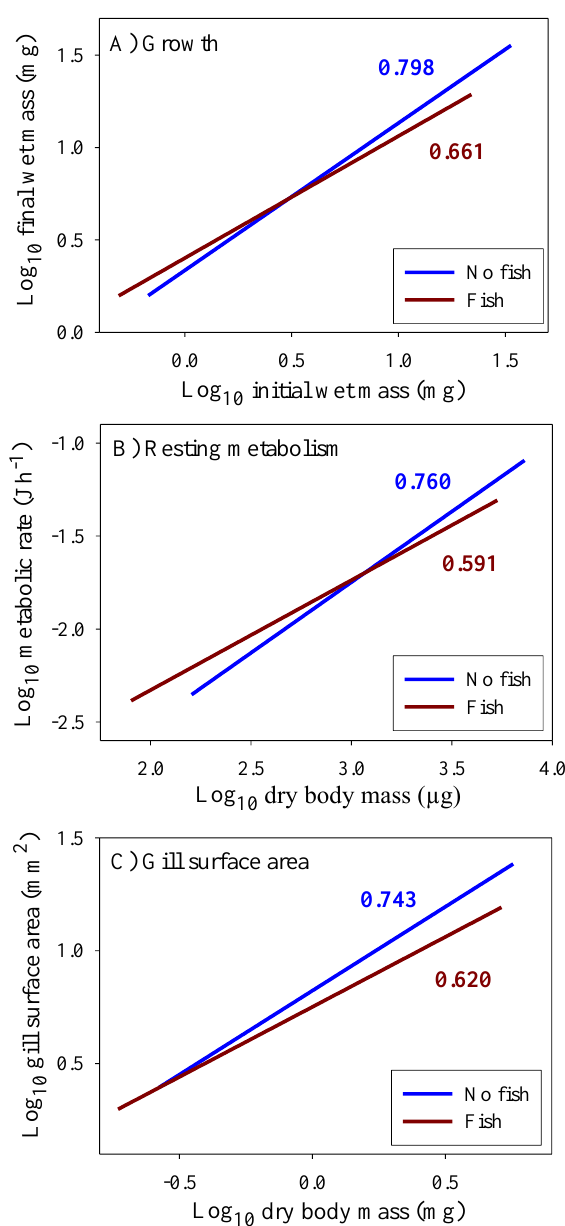
Figure 6. Comparisons of body-mass scaling relationships for growth rate, resting metabolic rate and gill surface area between population samples of Gammarus minus from springs with ( F ) versus without fish predators ( Cottus cognatus ) ( NF ). ( A ) Log 10 final wet mass in relation to log 10 initial wet mass (data for Petersburg, Kanesatake, Ell and Blue populations from [13]. The regression equations (including 95% confidence intervals for each parameter) are ( NF ): Y = 0.798 ( ± 0.030) X + 0.335 ( ± 0.030) ( r = 0.961; N = 228; P < 0.00001) and ( F ): Y = 0.661 ( ± 0.031) X + 0. ( ± 0.029) ( r = 0.952; N = 178; P < 0.00001). ( B ) Log 10 resting metabolic rate in relation to log 10 dry body mass (data for Petersburg, Kanesatake, Ell, Blue and Williamsburg populations from [13]). The regression equations are ( NF ): Y = 0.760 ( ± 0.080) X − 4.028 ( ± 0.252) ( r = 0.809; N = 190; P < 0.00001) and ( F ): Y = 0.591 ( ± 0.060) X − 3.511 ( ± 0.186) ( r = 0.725; N = 336; P < 0.00001). (C) Log 10 gill surface area in relation to log 10 dry body mass (data for Petersburg, Kanesatake, Big Rock, Ell, Blue and Williamsburg populations from [70]). The regression equations are ( NF ): Y = 0.743 ( ± 0.046) X + 0.823 ( ± 0.019) ( r = 0.962; N = 85; P < 0.00001) and ( F ): Y = 0.620 ( ± 0.084) X + 0.751 ( ± 0.025) ( r = 0.829; N = 100; P < 0.00001).